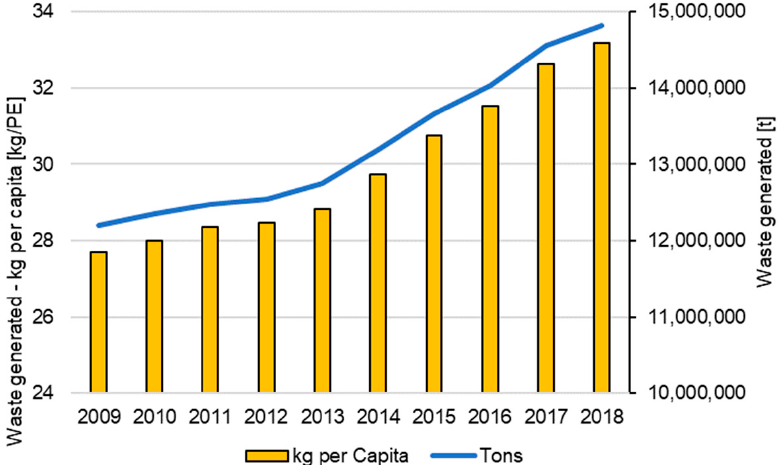
Figure 11. Plastic packaging—average waste generated in the EU from 2009 to 2018 [22].